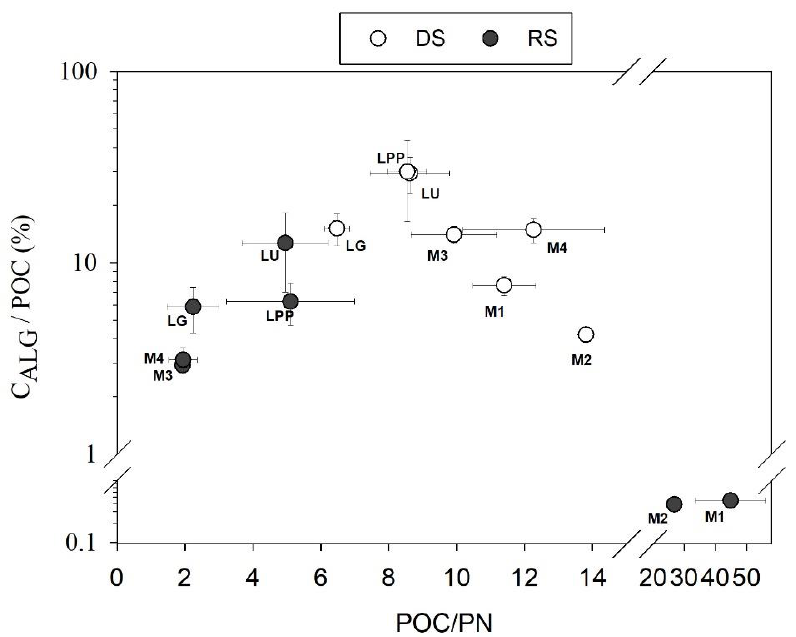
Figure 5. Mean algal biomass contribution to POC in the Usumacinta River as a function of the mean POC/PN ratio. The whiskers represent the standard deviations.